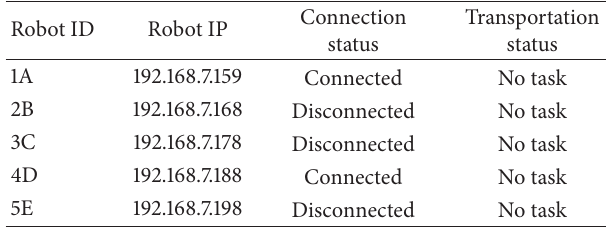
Table 3: Connecting robot to